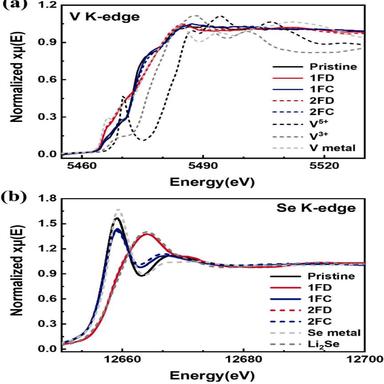
Normalized (a) V and (b) Se K-edge XANES spectra of V2Se9 during the first two cycles.